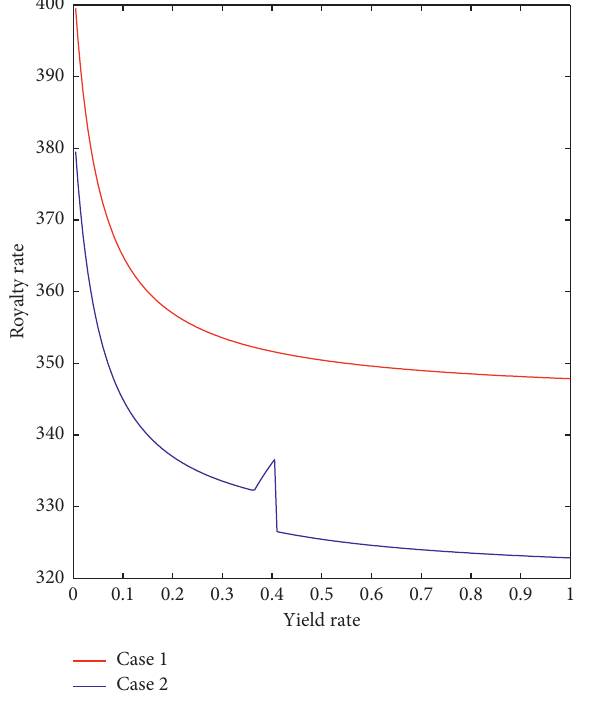
Figure 4: Royalty rate vs. yield rate.